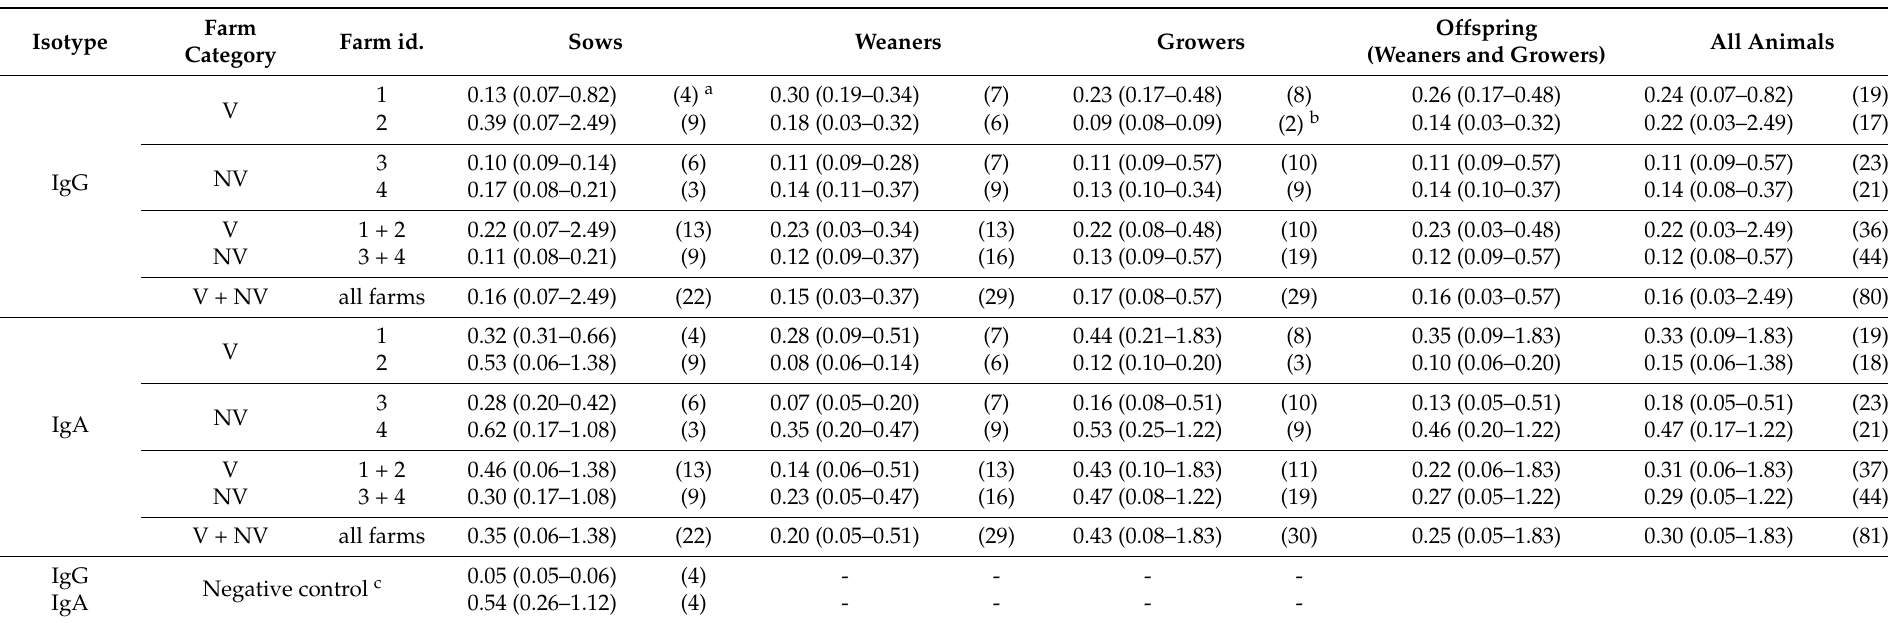
Table 2. Median ELISA OD values (min–max) for anti- Salmonella IgA and IgG antibodies detected using IDEXX ELISA in oral fluid (OF) samples from four